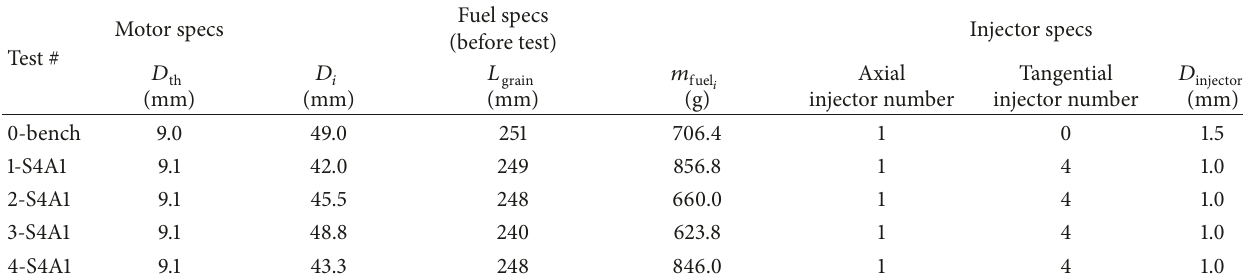
Table 4: Specification of tests.